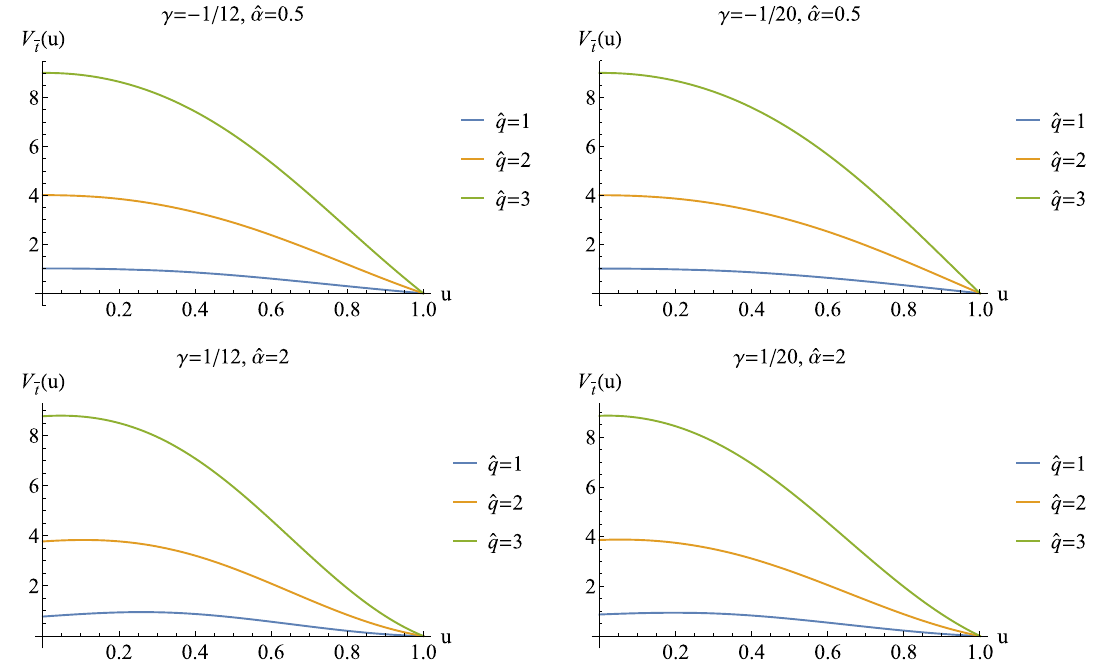
Fig. 17 The potentials V ¯ t ( u ) with different γ and ˆ α at some finite momentum. (For interpretation of the references to color in this figure, the reader is referred to the web version of this